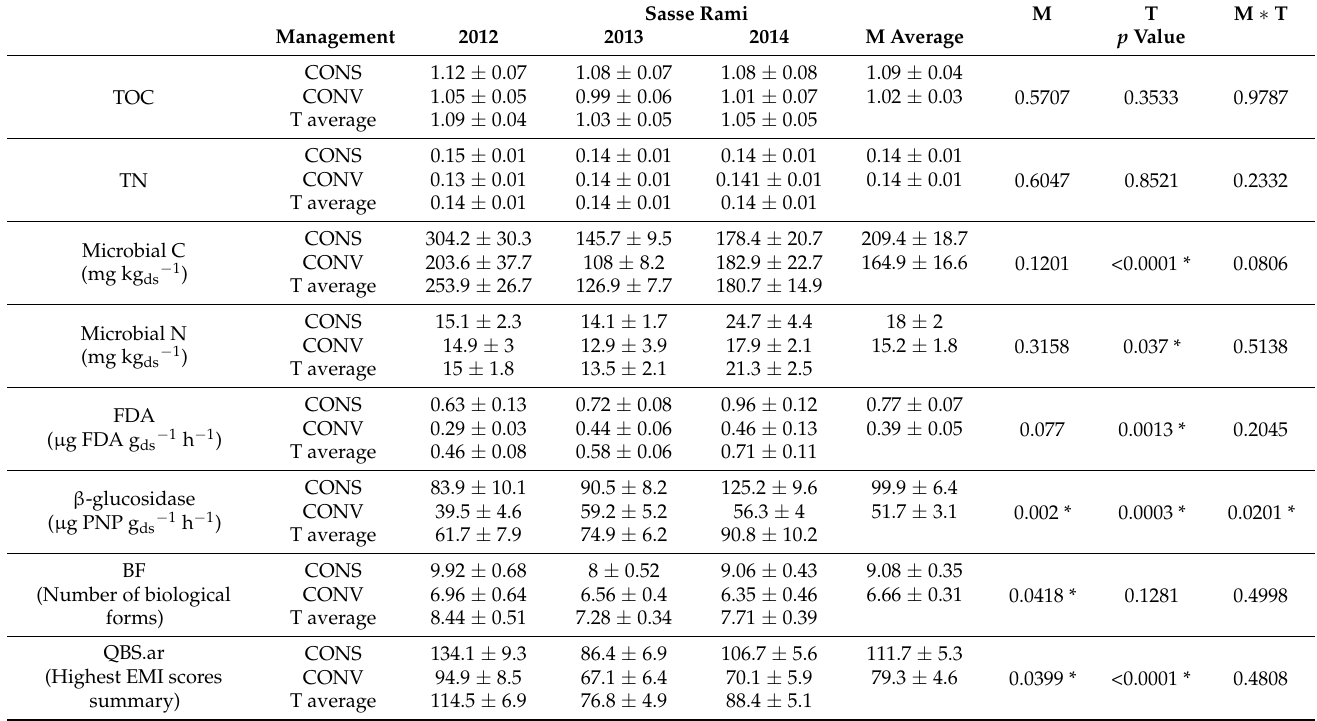
Table 4. Soil evolution in Sasse Rami